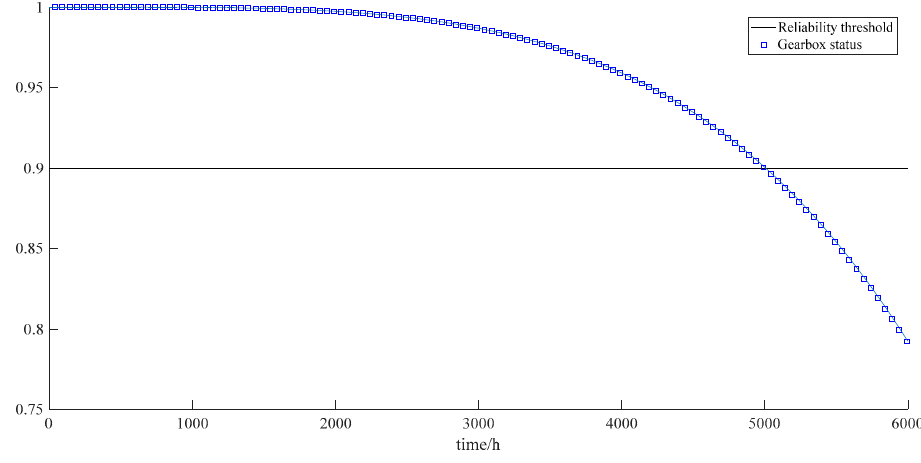
Figure 2. Gear box state transform diagram.